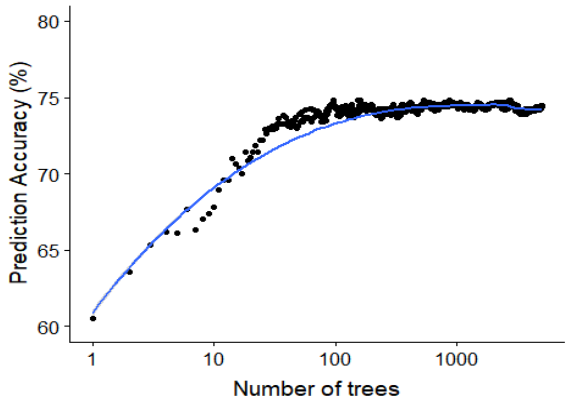
Figure 10. Saturating effect of increasing the number of classifiers in the random forest. The out-of-bag accuracy (an estimate of the test accuracy) plotted against the number of trees for the random forest model predicting the specific type of interaction. This is for a minimal node size of 1 and trying all possible features at every split.